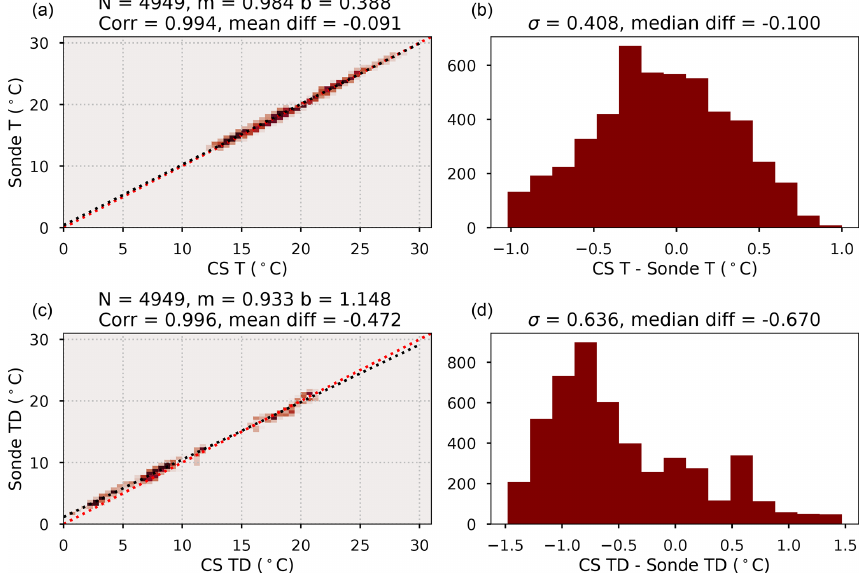
Figure 8. Similar to Fig. 5 but comparing measurements from the radiosondes and the